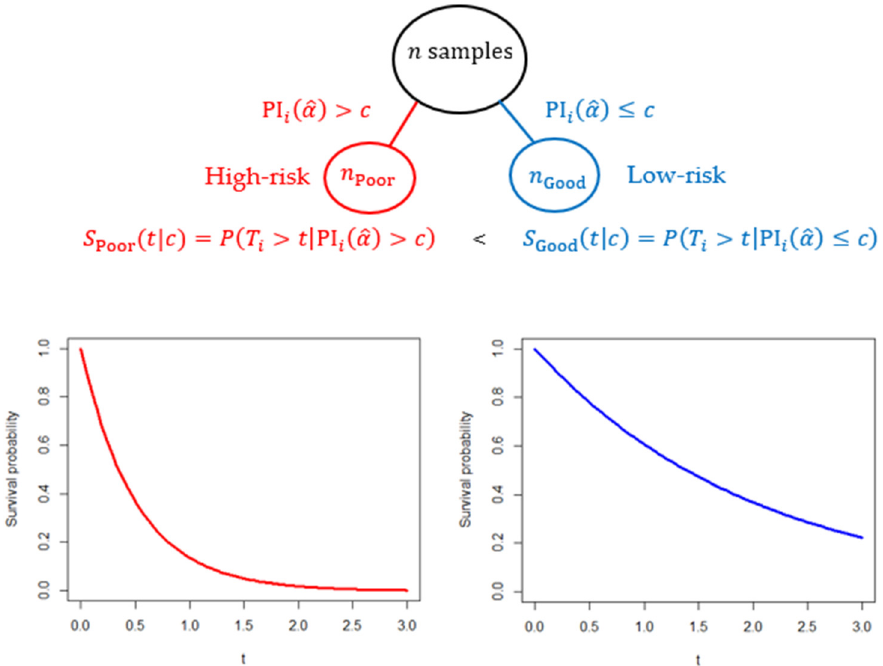
Figure 1. Good and poor prognosis group separated by the PI applied for the testing sample of size n . Concretely, { i ;PI i ( ˆ α ) ≤ c } is a good prognosis (low-risk) group, and { i ;PI i ( ˆ α ) > c } is a poor prognosis (high-risk) group. If the classification is successful, survival functions exhibit S Good ( t | c ) > S Poor ( t | c ) . The cut-off value c can be the median of the PI values calculated from the training samples.